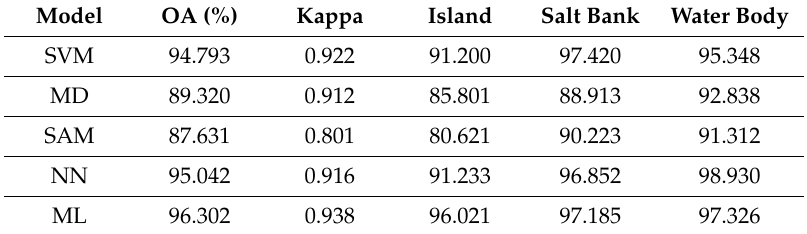
Table 4. Land area (km 2 ) by different supervised classification algorithms in 2017.